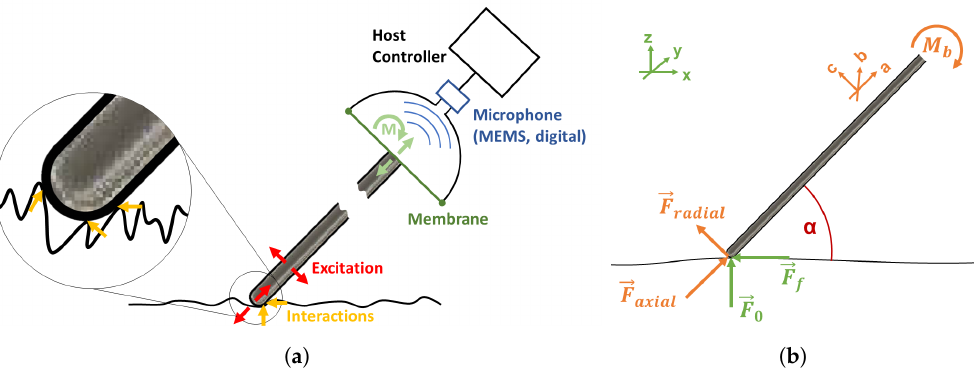
Figure 2. The working principle of the signal acquisition system ( a ) is based on the concept of a stethoscope. A membrane translates the structural vibrations due to instrument interactions to sound waves, which can be acquired with an airborne microphone. The free-body diagram ( b ) visualises the forces and moments originating from the instrument interaction during